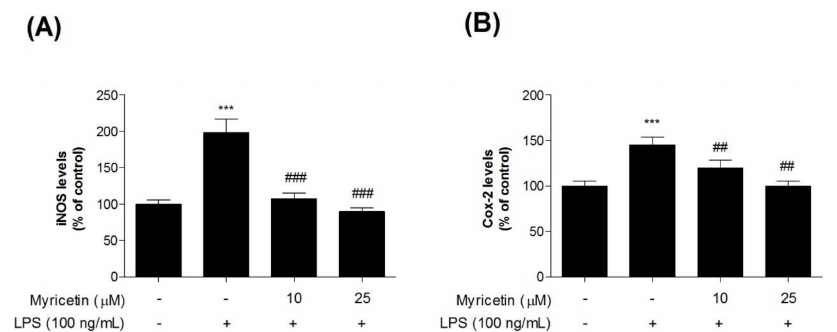
Figure 3. The e ff ect of myricetin on LPS-induced iNOS and COX-2 levels in microglia BV2 cells. Cells were treated with myricetin for 1 h, and then stimulated with LPS for an additional 23 h. ( a ) iNOS and ( b ) COX-2 levels were measured by ELISA kit. Values are means ± standard error of the mean. *** p < 0.001 compared to the control group, and ## p < 0.01 and ### p < 0.001 compared to the LPS-alone group. LPS, lipopolysaccharide; iNOS, inducible nitric oxide synthase; COX-2, cyclooxygenase-2.